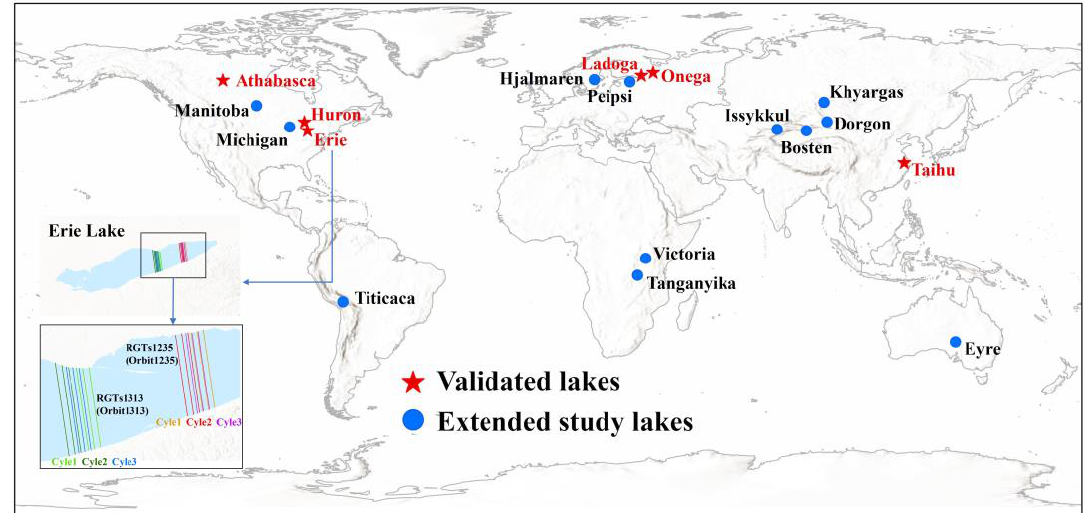
Figure 1. Location of the validated lakes (red stars) and extended study lakes (blue bubbles). The insert map of one example lake (Erie Lake) illustrated the measurements of two-orbit ICESat-2 altimetry observations (lines represent the ICESat-2 footprints of two orbits with three revisit cycles).